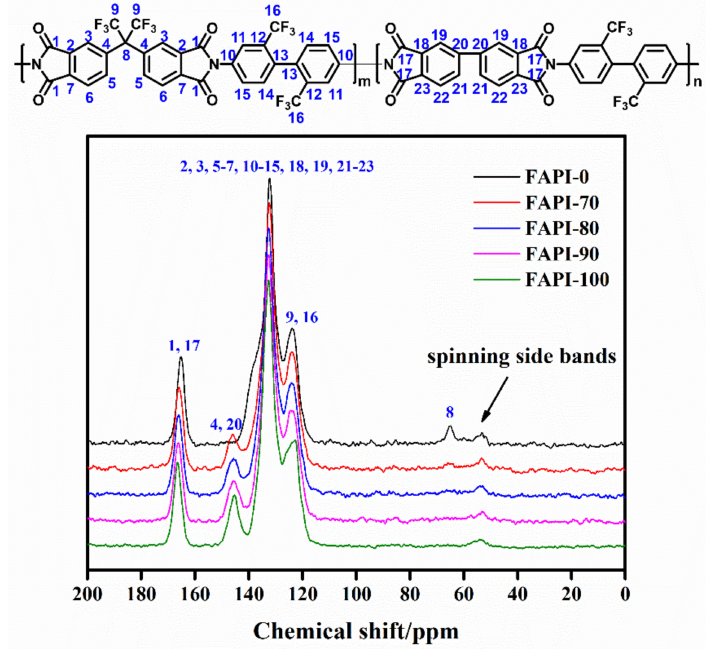
Figure 2. 13 C solid state NMR spectra of the FAPI films with different biphenyl group content in polymer